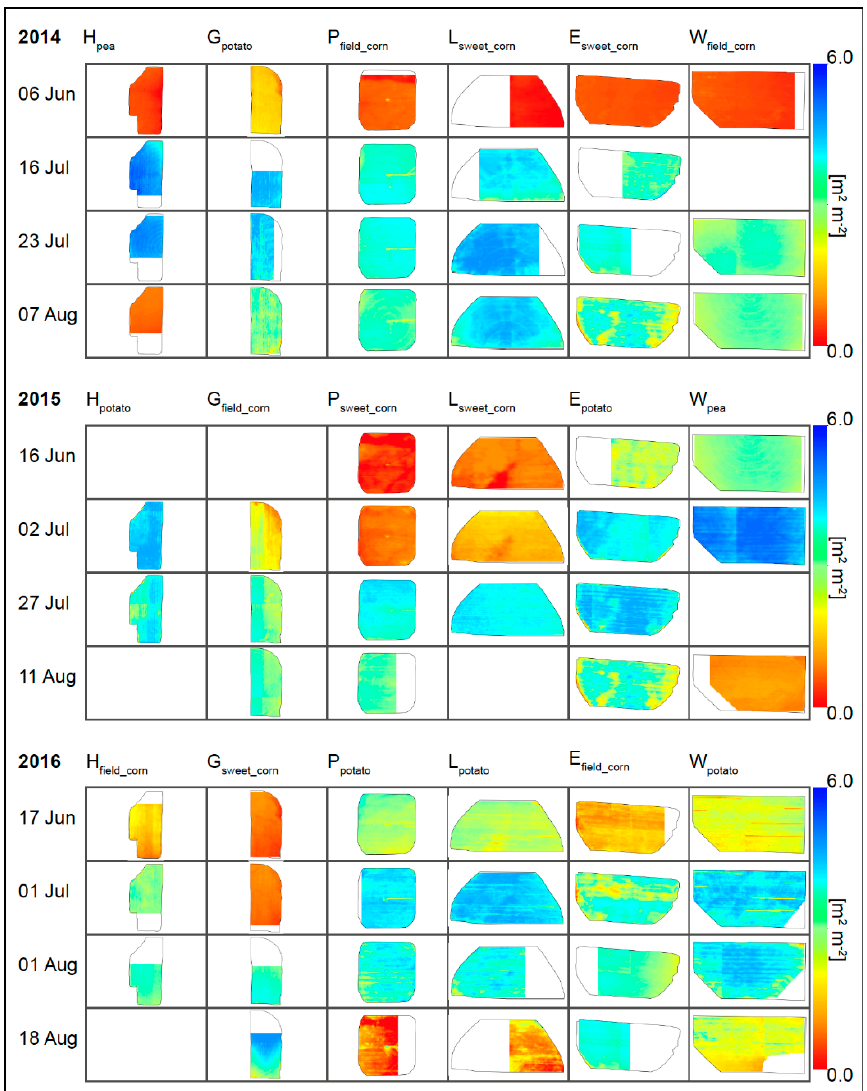
Figure 3. Leaf area index (m 2 m − 2 ) for fields H, G, P, L, E, and W for twelve airborne missions in 2014–2016. All maps are linearly scaled to the same color bar. Blank spaces indicate missing imagery because of cloud interference during missions.